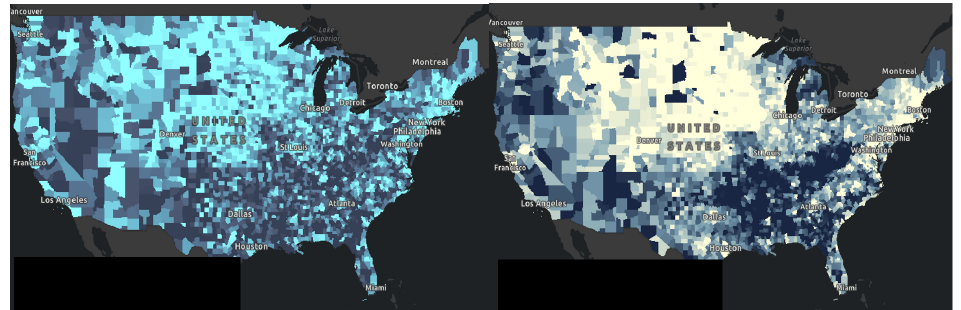
Figure 6. ( Left ) Mean, standard deviation, and geographic distribution of percentage of individuals between the ages of 25–44 with at least some college education (left = lighter colors represent higher percentages). ( Right ) In comparison, mean, standard deviation, and geographic distribution of percentage of adults reporting 14 or more days of poor physical health per month (right = darker colors represent higher percentages). The shade of color in the map corresponds to the value designated in the colored shading in the figure above.